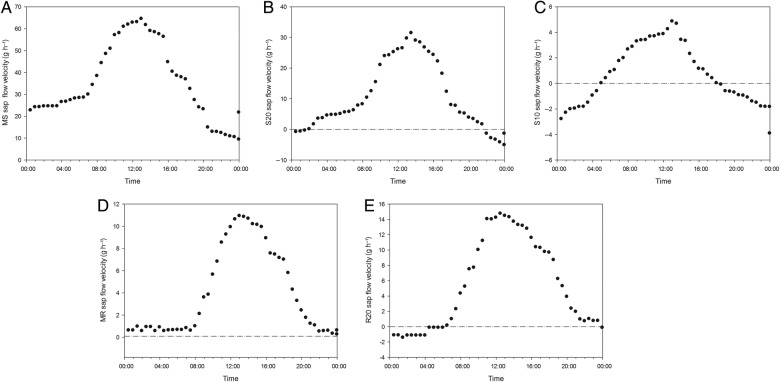
Diurnal variation in sap velocity at different positions of the sapwood of T. ramosissima. (A) For the main stem with a diameter of ∼30 cm (MS), (B) for the stem with a diameter of ∼20 cm (S20), (C) for the stem with a diameter of ∼10 cm (S10), (D) for the main root with a diameter of ∼30 cm (MR) and (E) for the root with a diameter of ∼20 cm (R20). The null sap flow velocity is marked with a dashed dotted line, which was used as a transition criterion to determine whether foliar water uptake occurred.